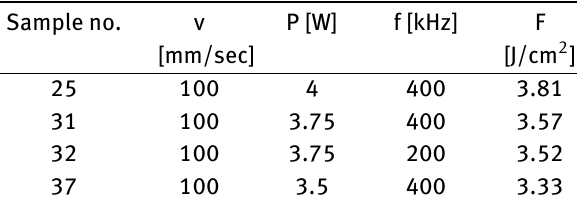
Table 5: Processing parameters of samples of the highest desirabil-